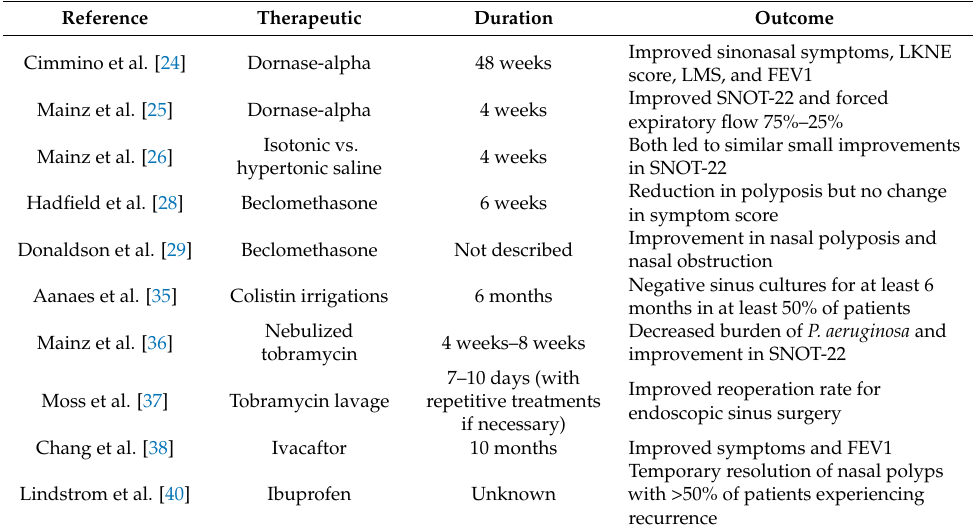
Table 1. Summary of medical management used to treat cystic fibrosis